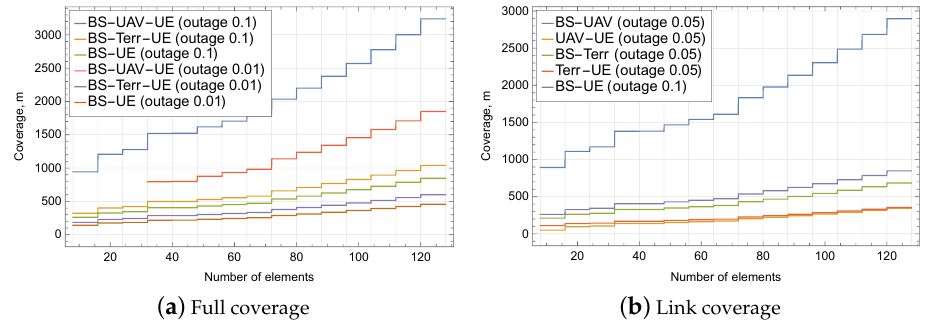
Figure 3. Single BS coverage as a function of deployment option.